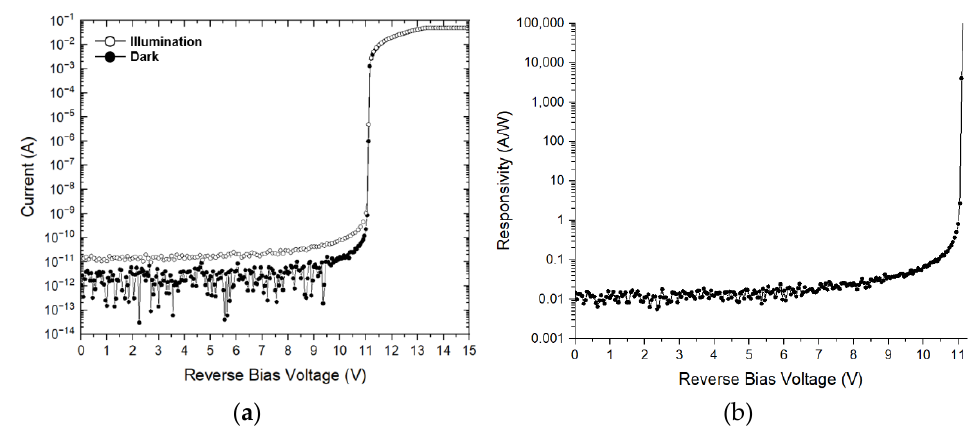
Figure 9. ( a ) Measured I – V curve of the P + /N-well APD and (b) its responsivity.